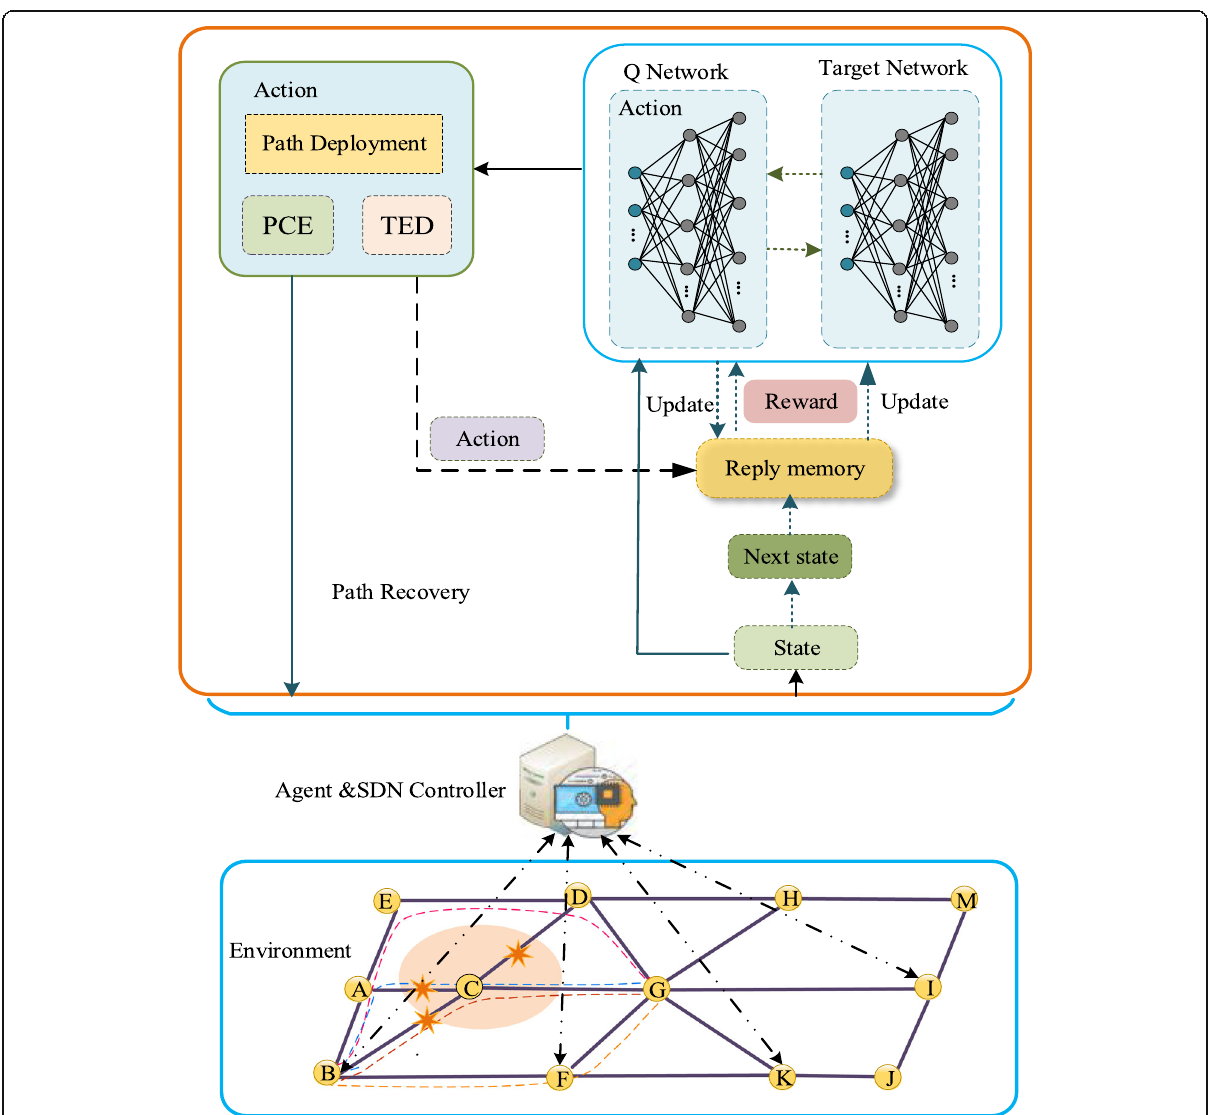
Fig. 5 DQN-based optimization framework for SGCN. This figure shows the execution of DRL combined with